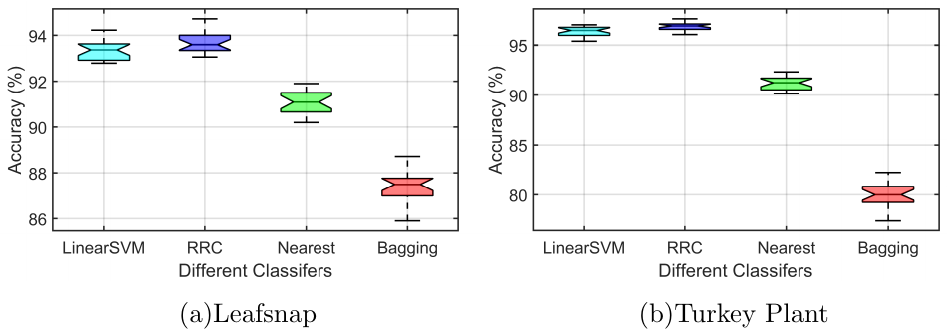
Figure 17. Recognition performance of four classifiers on two complicated